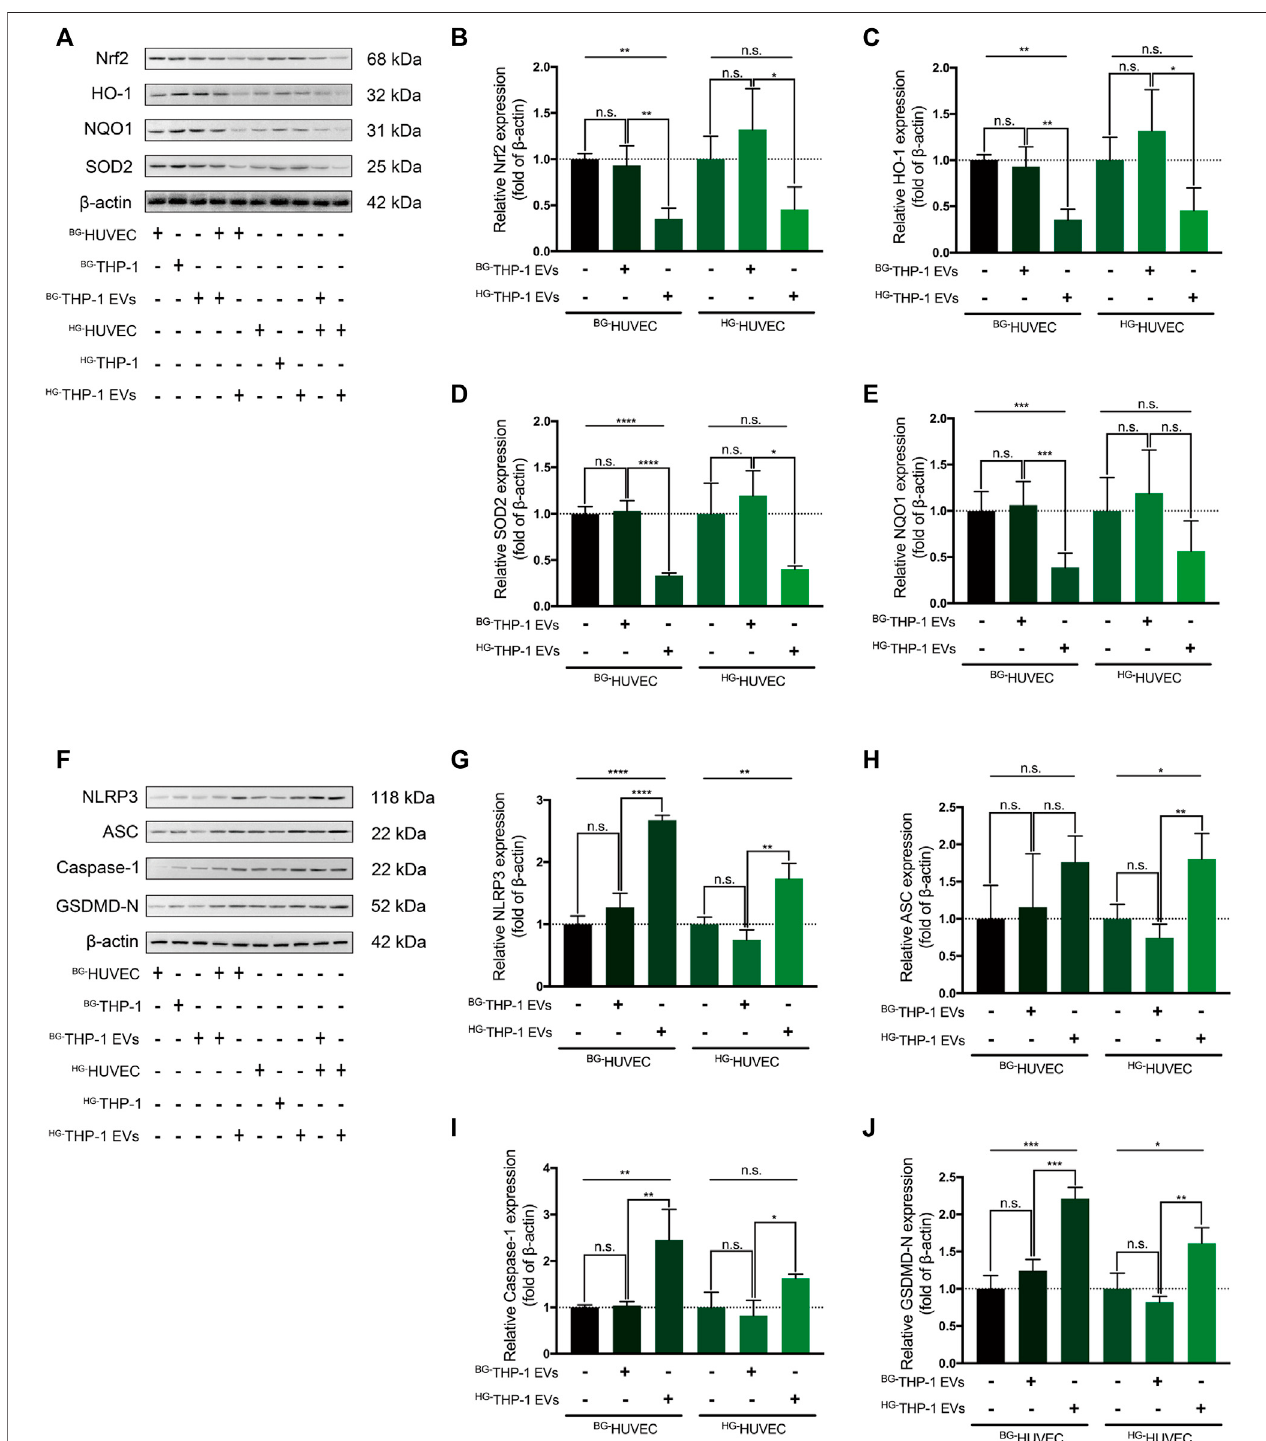
FIGURE 3 | HG- THP-1 EVs regulate the Nrf2 and NLRP3 signaling pathway in HUVECs (A – E) THP-1 EVs regulating the expression of Nrf2, HO-1, SOD2, and NQO1 in HUVECs, in which HG- THP-1 EVs signi fi cantly inhibited the level of the Nrf2 pathway signaling both in BG- HUVEC and HG- HUVEC (F – J) HG- THP-1 EVs signi fi cantly increased the expression of NLRP3, ASC, Caspase-1, and GSDMD-N both in BG- HUVEC and HG- HUVEC. HUVECs, human umbilical vein endothelial cells. Data are presented as mean ± SD and analyzed using the ANOVA, n. s not signi fi cant, * p < 0.05, ** p < 0.01, *** p < 0.001, **** p < 0.0001. n = 3.